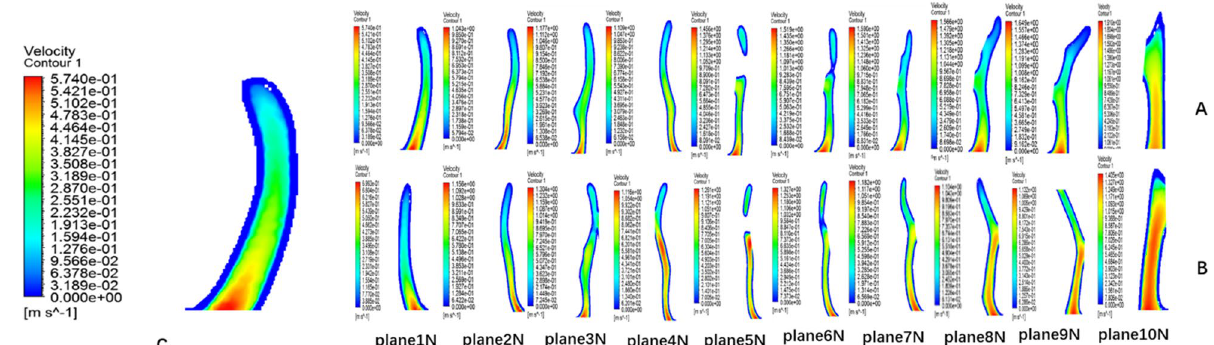
Figure 2. Airflow velocity diagram in the olfactory cleft area (plane1N- plane10N represent ten cross- sectional systems). ( A ) The airflow velocity of the right olfactory cleft; ( B ) The airflow velocity of the left side of the olfactory cleft.c:the airflow velocity of the initial plane of the left olfactory fissure. (created by ANSYS 17.0: Academic Teaching Mechanical and CFD, ANSYS END USER CERTIFICATE, Sun Yat-sen